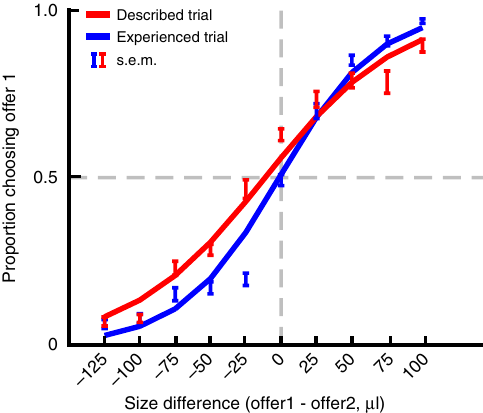
Figure 2 | Behavior. Probability of choosing offer 1 as a function of value difference between offer 1 and 2. Preference curves were roughly sigmoidal. Subjects generally chose the higher value offer. Performance was slightly but significantly more optimal (that is, reward-maximizing) for experienced than for described offers.